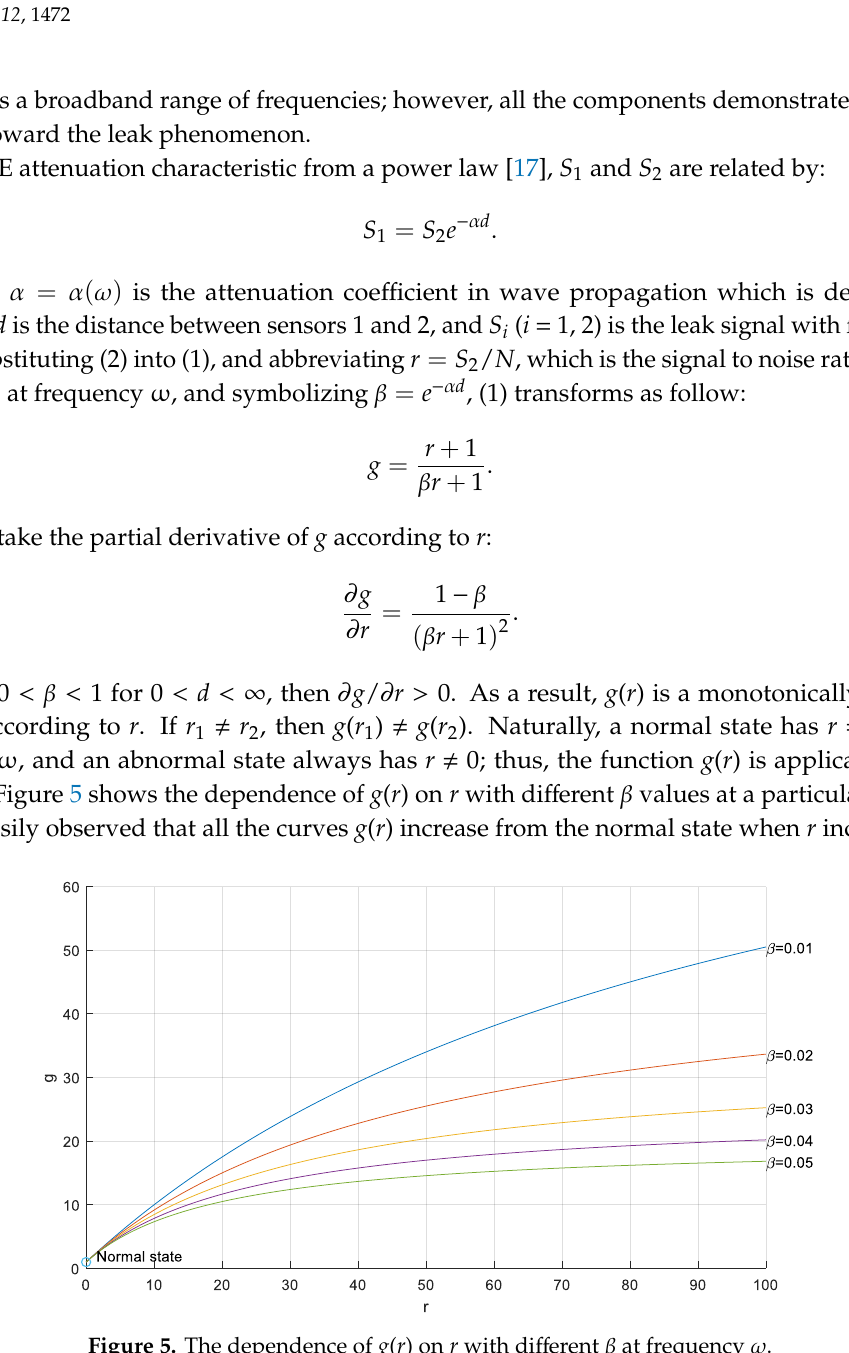
Figure 5. The dependence of g ( r ) on r with different β at frequency ω .